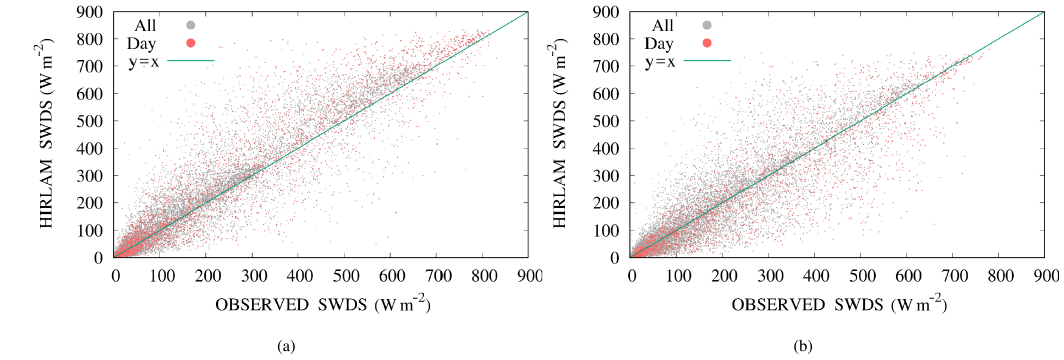
Figure 6. All predicted vs. observed SWDS: (a) Jokioinen and (b) Sodankylä. Afternoon fluxes (11:00–14:00UTC or 12:00–15:00 local time) are shown in red, grey dots denote all